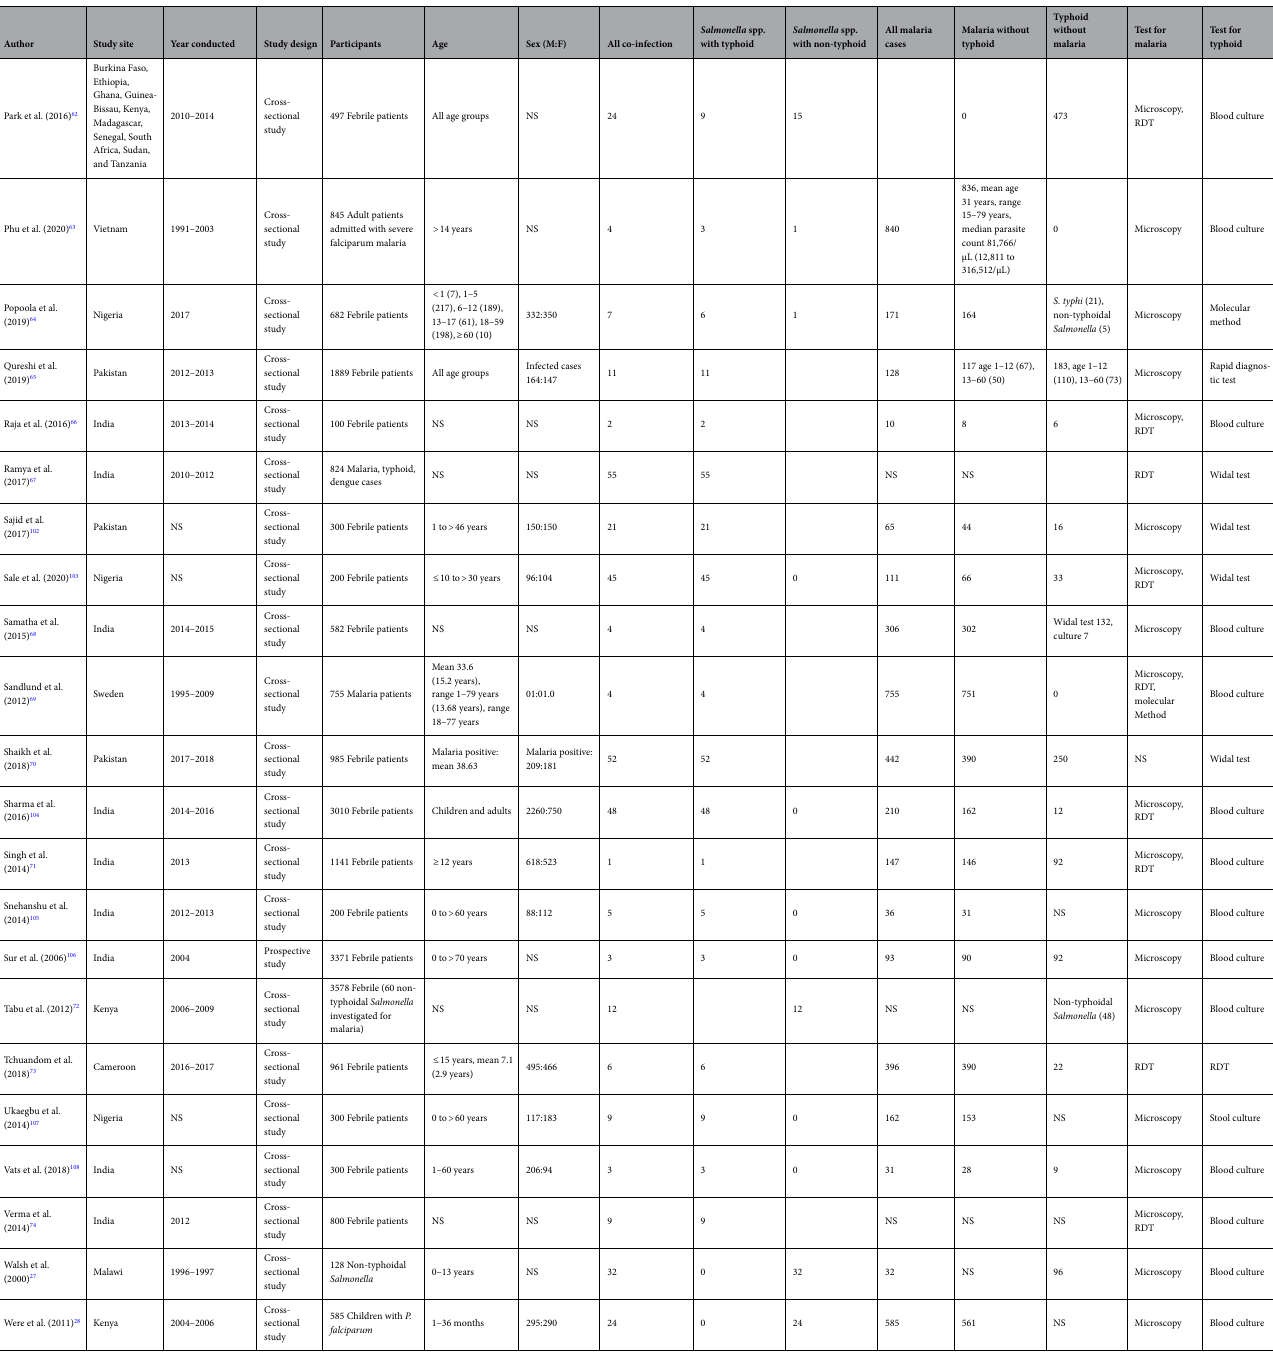
Table 1. Characteristics of the included studies. ELISA enzyme-linked immunosorbent assay, NS not specified, RDT rapid diagnostic